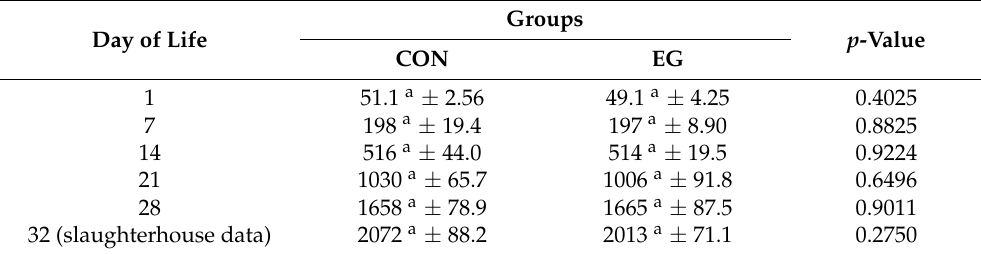
32 (slaughterhouse data)